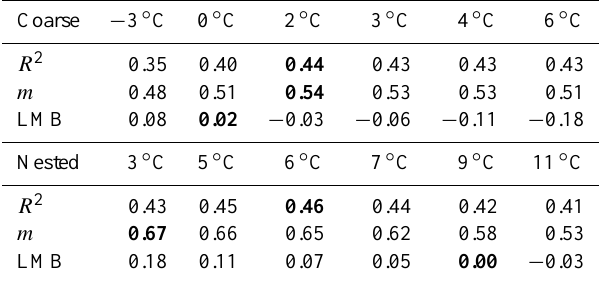
Table 3. Summary of the slope of the linear regression ( m ), cor- relation ( R 2 ) , and log-mean bias (LMB) for different temperature cutoffs for coarse and nested simulations. These statistics are found by comparing the simulated aerosol number concentrations during the measurement period to measurements at Whistler Peak for vari- ous temperature cutoffs with the 90%RH filtering included. Bolded numbers represent the best statistical result between all